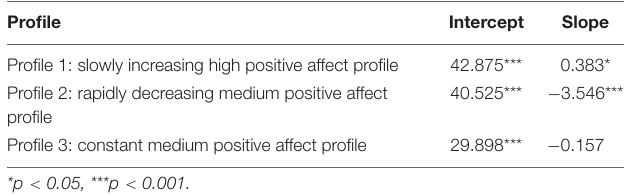
TABLE 6 | The intercepts and slopes of every group for the positive affect.